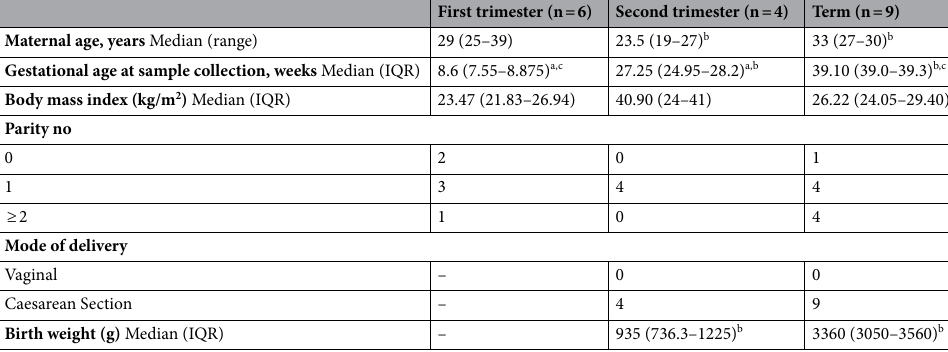
Table 2. Patient characteristics for placental tissue used to assess DAAM2 expression across gestation. BMI data unavailable for n = 1 second trimester sample. a Significant difference between first trimester and second trimester samples. b Significant difference between second trimester and term samples. c Significant difference between first trimester and term samples.